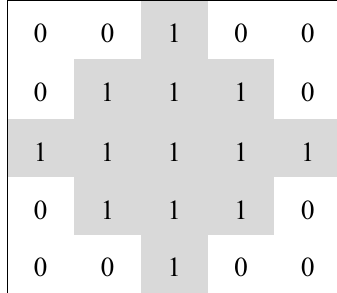
Figure 2. The 5 × 5 filter configuration used in CA_Markov.